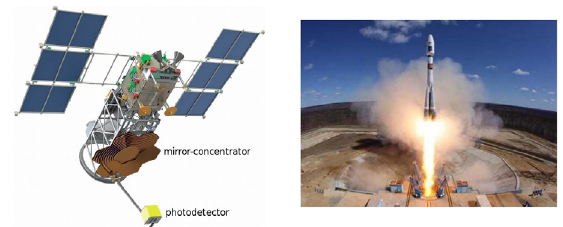
Figure 1. Left: scheme of the TUS detector on-board the “Lomonosov” satellite. Right: the launch of the satellite on April 28,